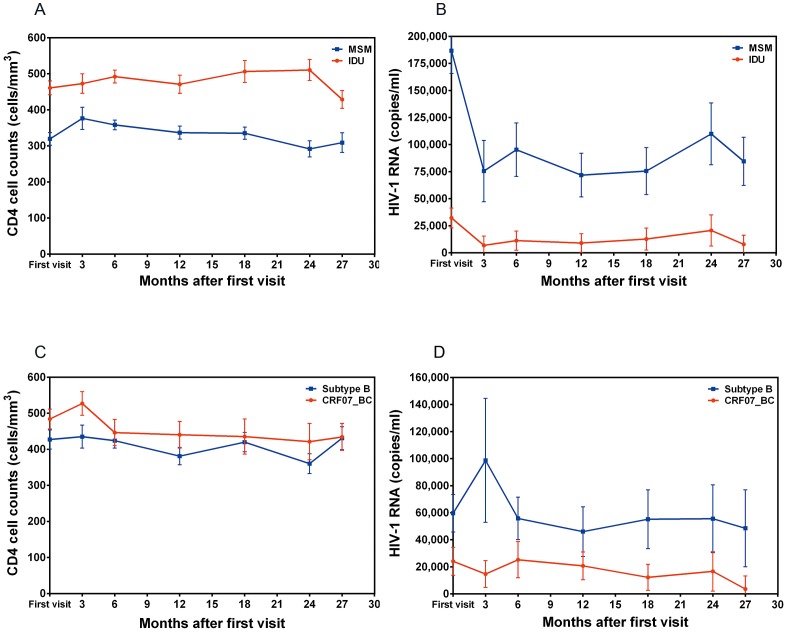
Comparisons of the changes of CD4 cell count and HIV-1 viral loads after the first clinical visit among the following four groups of treatment naïve patients.Men who have sex with men (MSM, 357 patients for CD4 cell count and 371 patients for viral loads analysis) vs. injection drug users (IDUs, 129 patients for CD4 cell count and 128 patients for viral loads analysis) (Fig. 1A and 1B); patients infected with CRF07_BC vs. infected with subtype B (Figs. 1C and 1D). A generalized estimating equation model was used for the analyses.